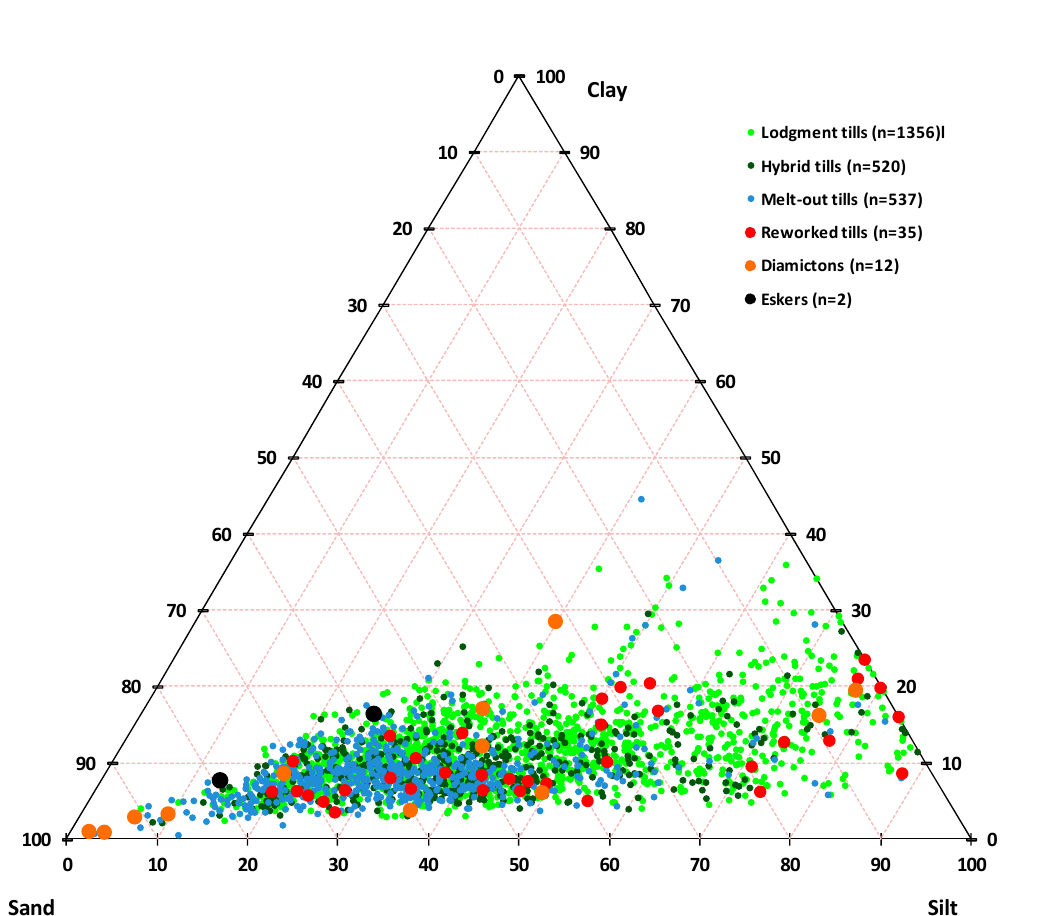
Figure 2. Sand, silt and clay proportions in 2462 till samples from northwestern Qu é bec and northeastern Ontario. Particles larger than 1 mm were excluded, their proportion being too erratic. Grain size distribution is obtained from a laser dispersion grain sizer (Fritsch Analysette 22, using the Fraunhofer equations. While the clay ( − 4 µ m) to silt (4–63 µ m) ratio is quite constant, the sand (63–1000 µ m) abundance increases from lodgment till, to hybrid till to fusion (melt-out) till. Reworked material, diamicton and fluvioglacial show large scattering.